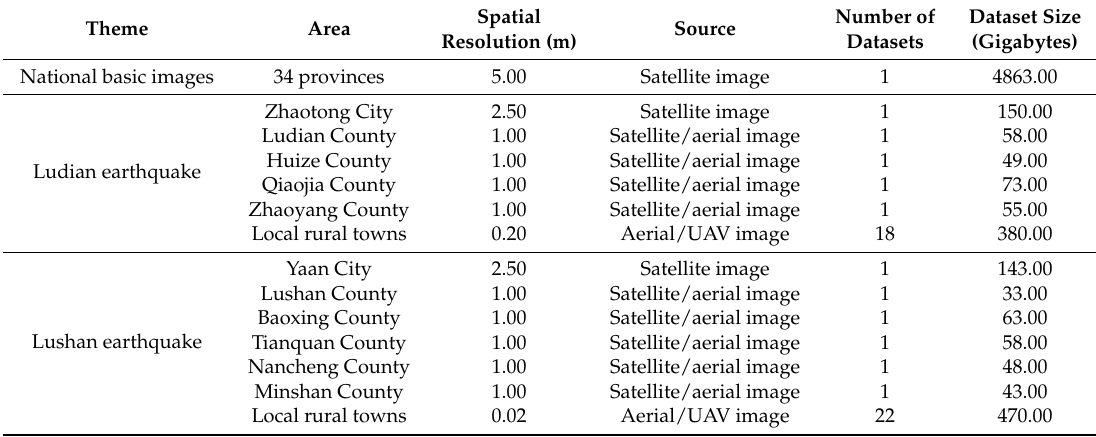
Table 1. Details of experimental